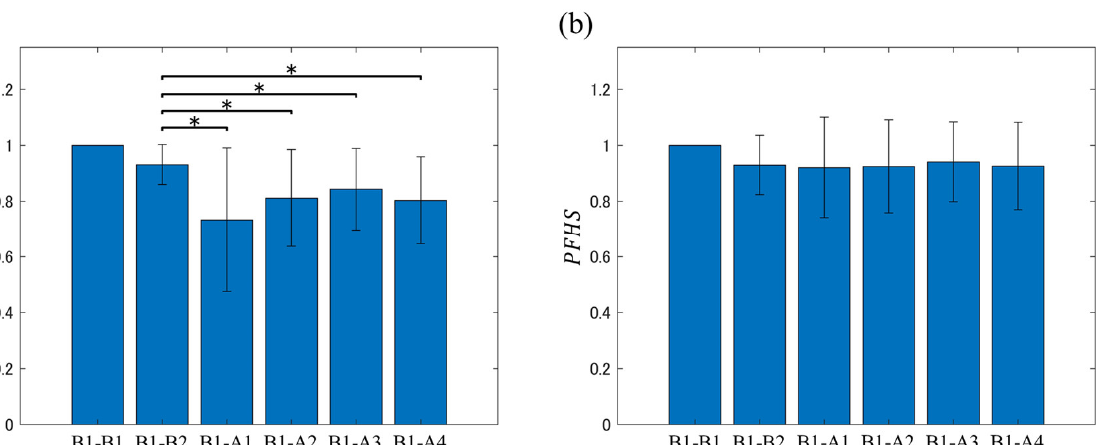
Figure 5. Analysis interval based on a 2.5-min time interval; before liquid intake: B1, B2; after liquid intake: A1, A2, A3, A4.